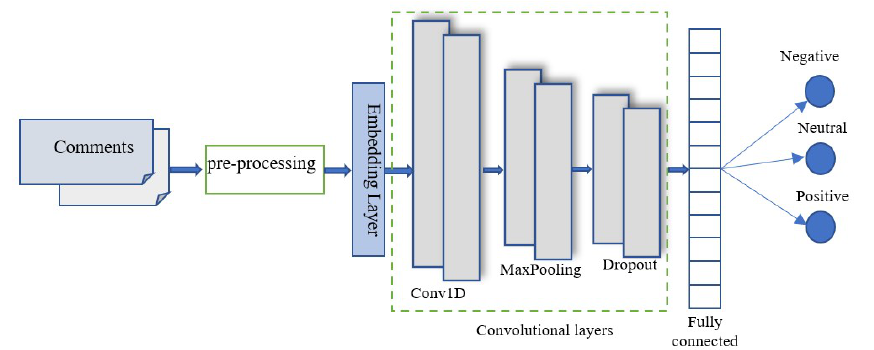
Figure 4. The proposed CNN architecture for sentiment